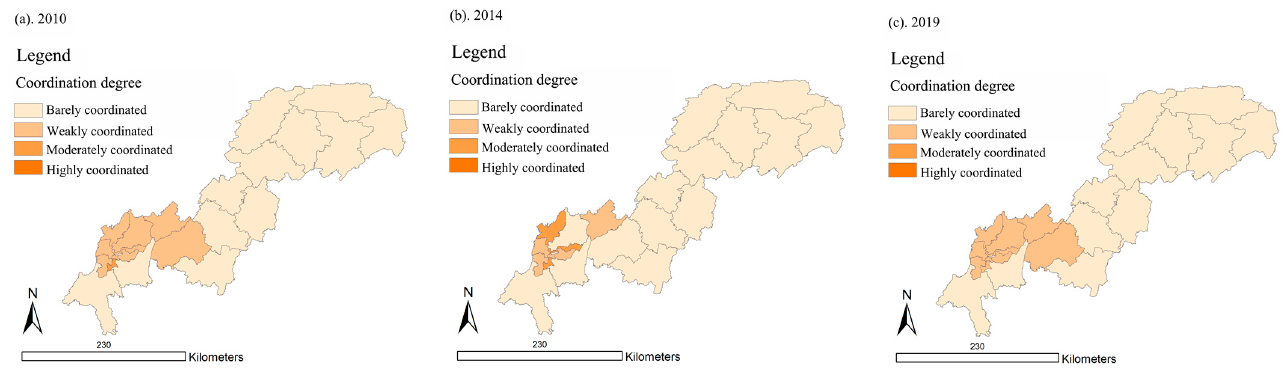
Figure 10. Spatial distribution of coordination degree in the Three Gorges Reservoir Area (Chongqing section) in year 2010, 2014, and 2019 (presented in subfigure a – c , respectively). Sources: Calculation results of the CCD model.